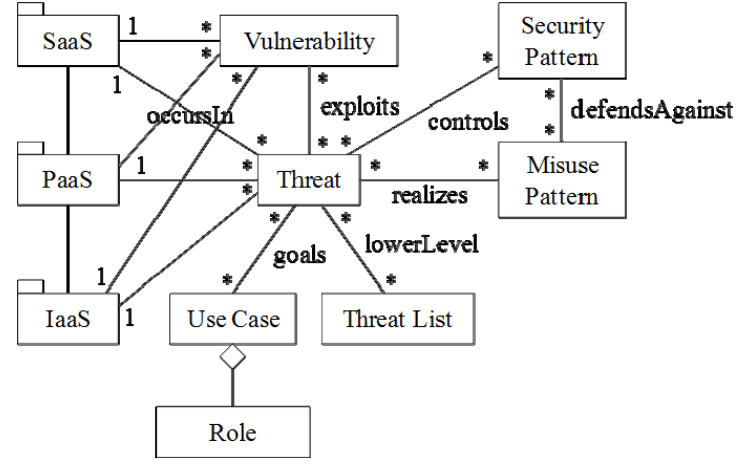
Figure 8. Metamodel for security concepts.